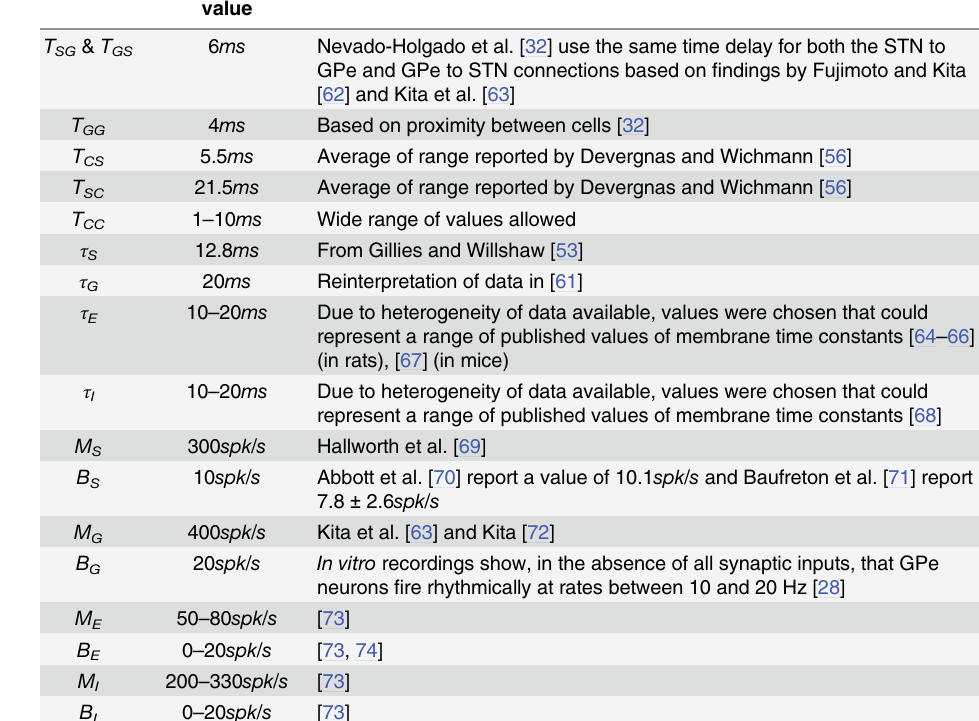
Table 1. The parameters and their values used together with the sources for this information. Parameter Parameter